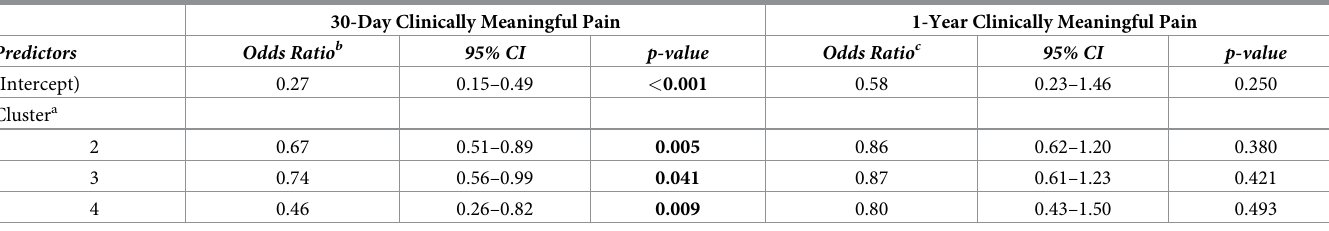
Table 2. Logistic regression models of 30-day and 1-year Moderate/Severe